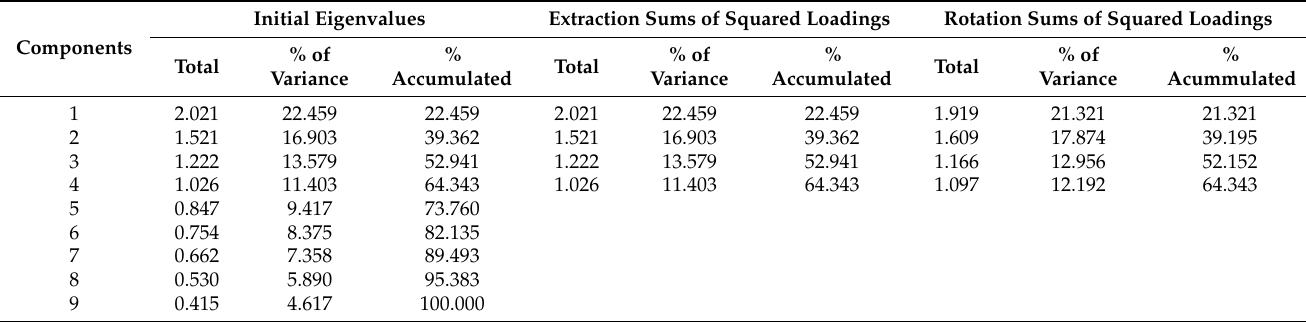
Table 2. Total variance explained.